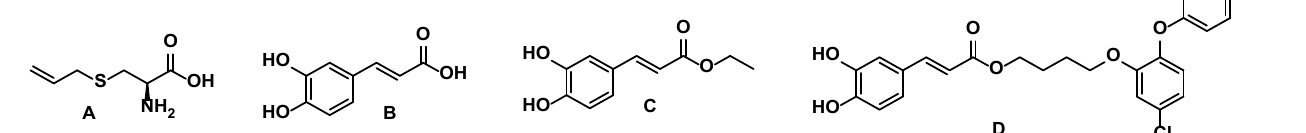
FIGURE 2 - Chemical structures of allylcysteine, caffeic acid and caffeic acid derivatives.